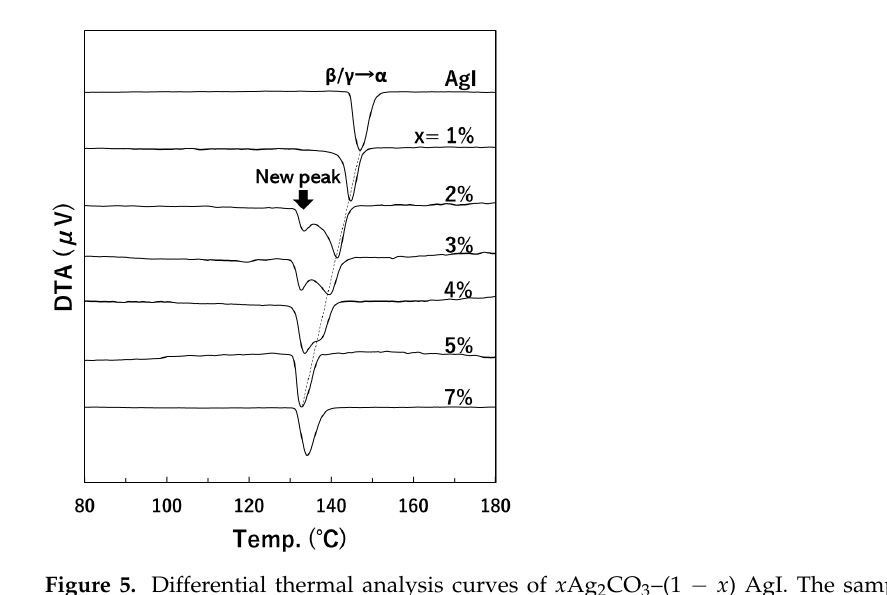
Figure 4. Electrical conductivity of x Ag 2 CO 3 –(1 − x ) AgI at room temperature ( a ) and XRD pattern of the x = 7% sample pretreated with uniaxial pressing, showing the occurrence of small peaks of Ag 17 (CO 3 ) 3 I 11 ( b ).